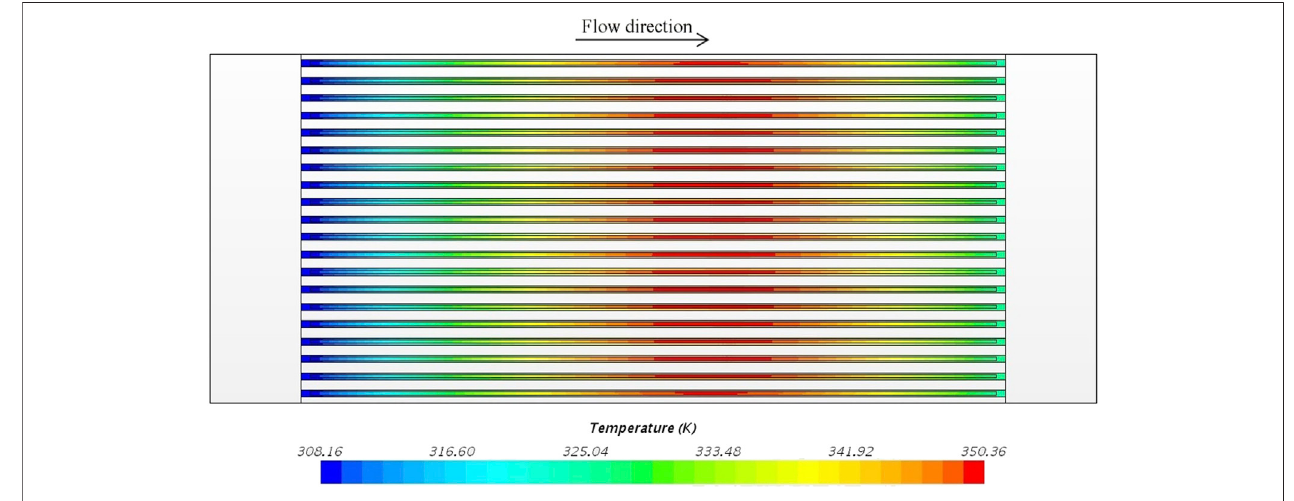
FIGURE 5 | Temperature distribution of the fuel plates (scale: x : z (cid:1) 1:5).